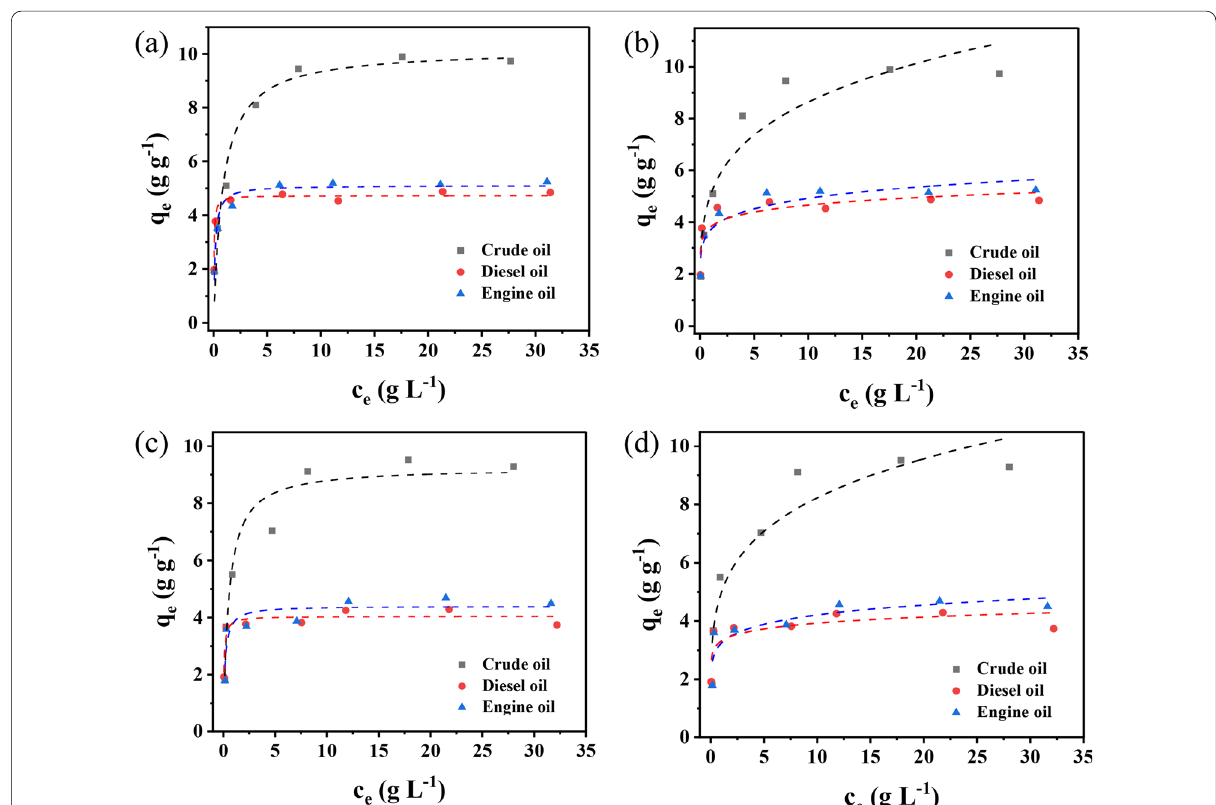
Fig. 8 The Langmuir isotherm model of oil sorption on CSBC (350 ℃ ) ( a ), OMBC ( c ). The Freundlich isotherm model of oil sorption on CSBC (350 ℃ ) ( b ), OMBC ( d